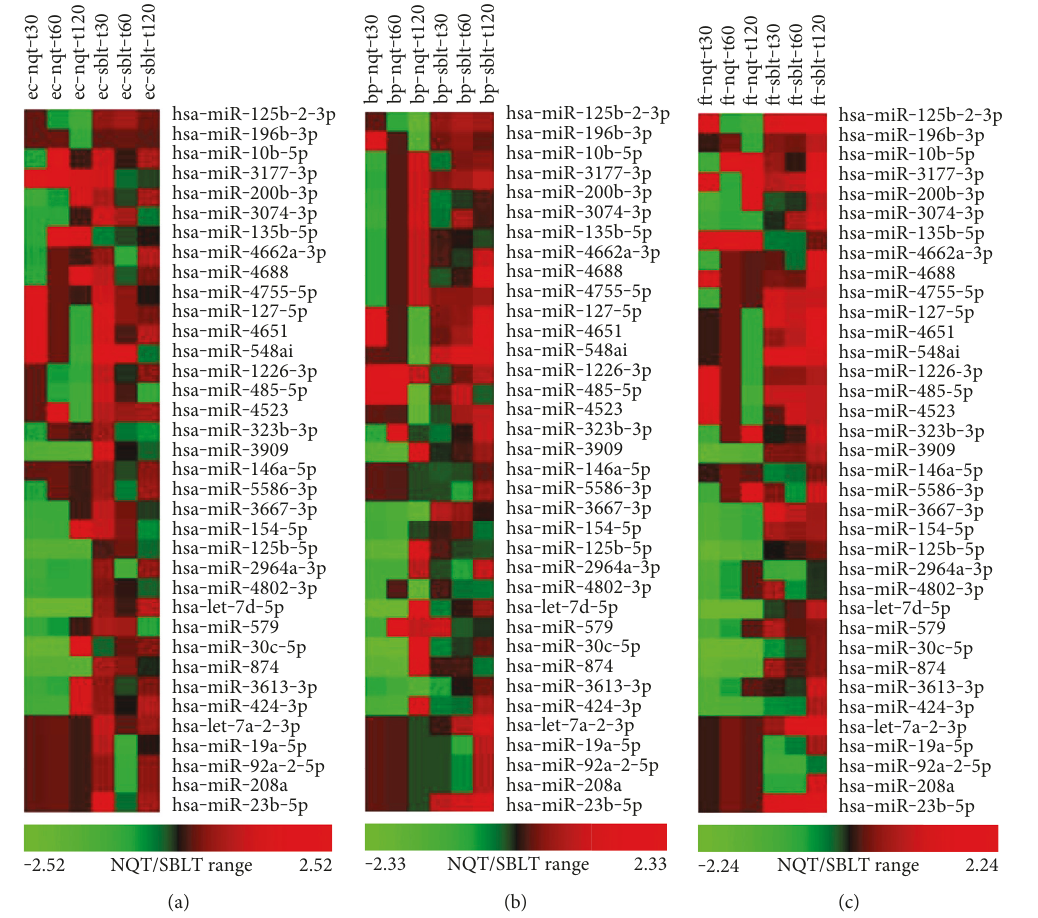
Figure 3: Heatmap of RNAseq (NQT) versus qPCR (SBLT) data for 36 miRNA tested in miScript qPCR. Here, RNAseq (NQT) data is shown in the fi rst three columns, and qPCR (SBLT) data are shown in the last three columns for each experiment. The miRNAs with a correlation coe ffi cient r > 0 95 are as follows: (a) E. coli - (ec-) exposed hPBMCs: hsa-miR-4755-5p; (b) B. pseudomallei - (bp-) exposed hPBMCs: